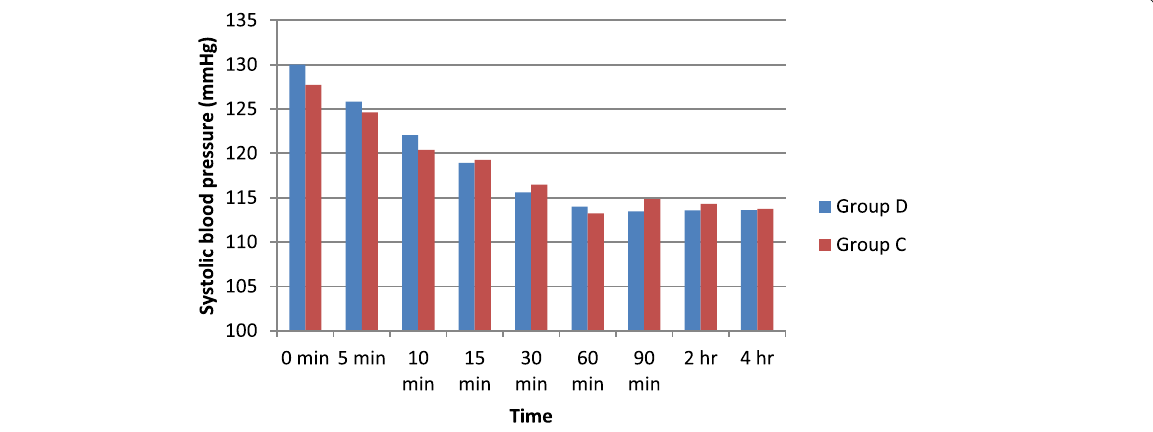
Fig. 5 Comparison of systolic blood pressure at different time intervals in both the